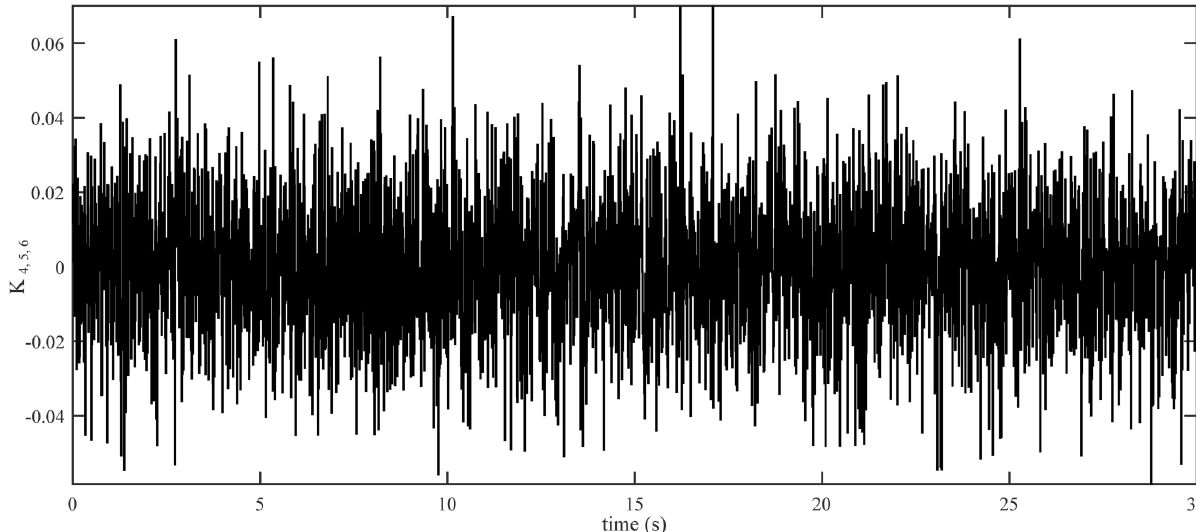
Fig 12. Drag coefficients for translational motion.